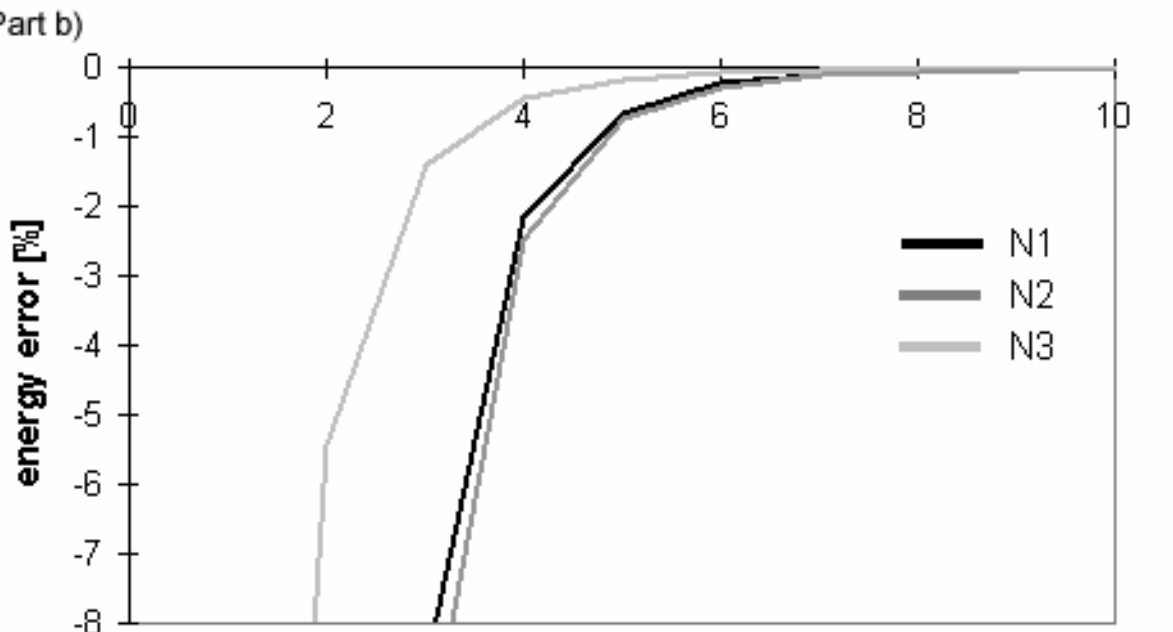
Figure 11. Dependency of energy error on cutoff for conformers of nucleotide-sugar. Energy error is calculated for E using cutoff method (Part a)) and PME method (Part vdw